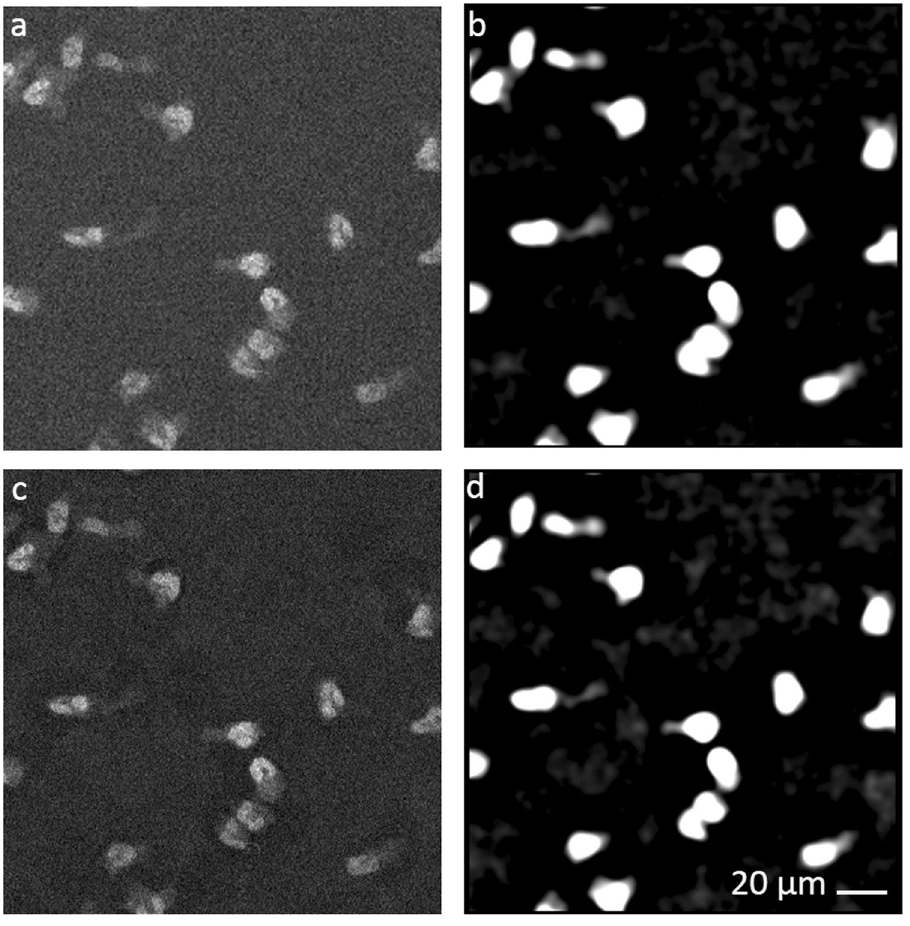
Figure 3. Cell detection by feature enhancement. Examples of the impact of different feature enhancement algorithms. ( a ) Original image. ( b ) Frequency filtering. ( c ) Background subtraction. ( d ) Background subtraction followed by a frequency filtering. Scale bar: 20 µ